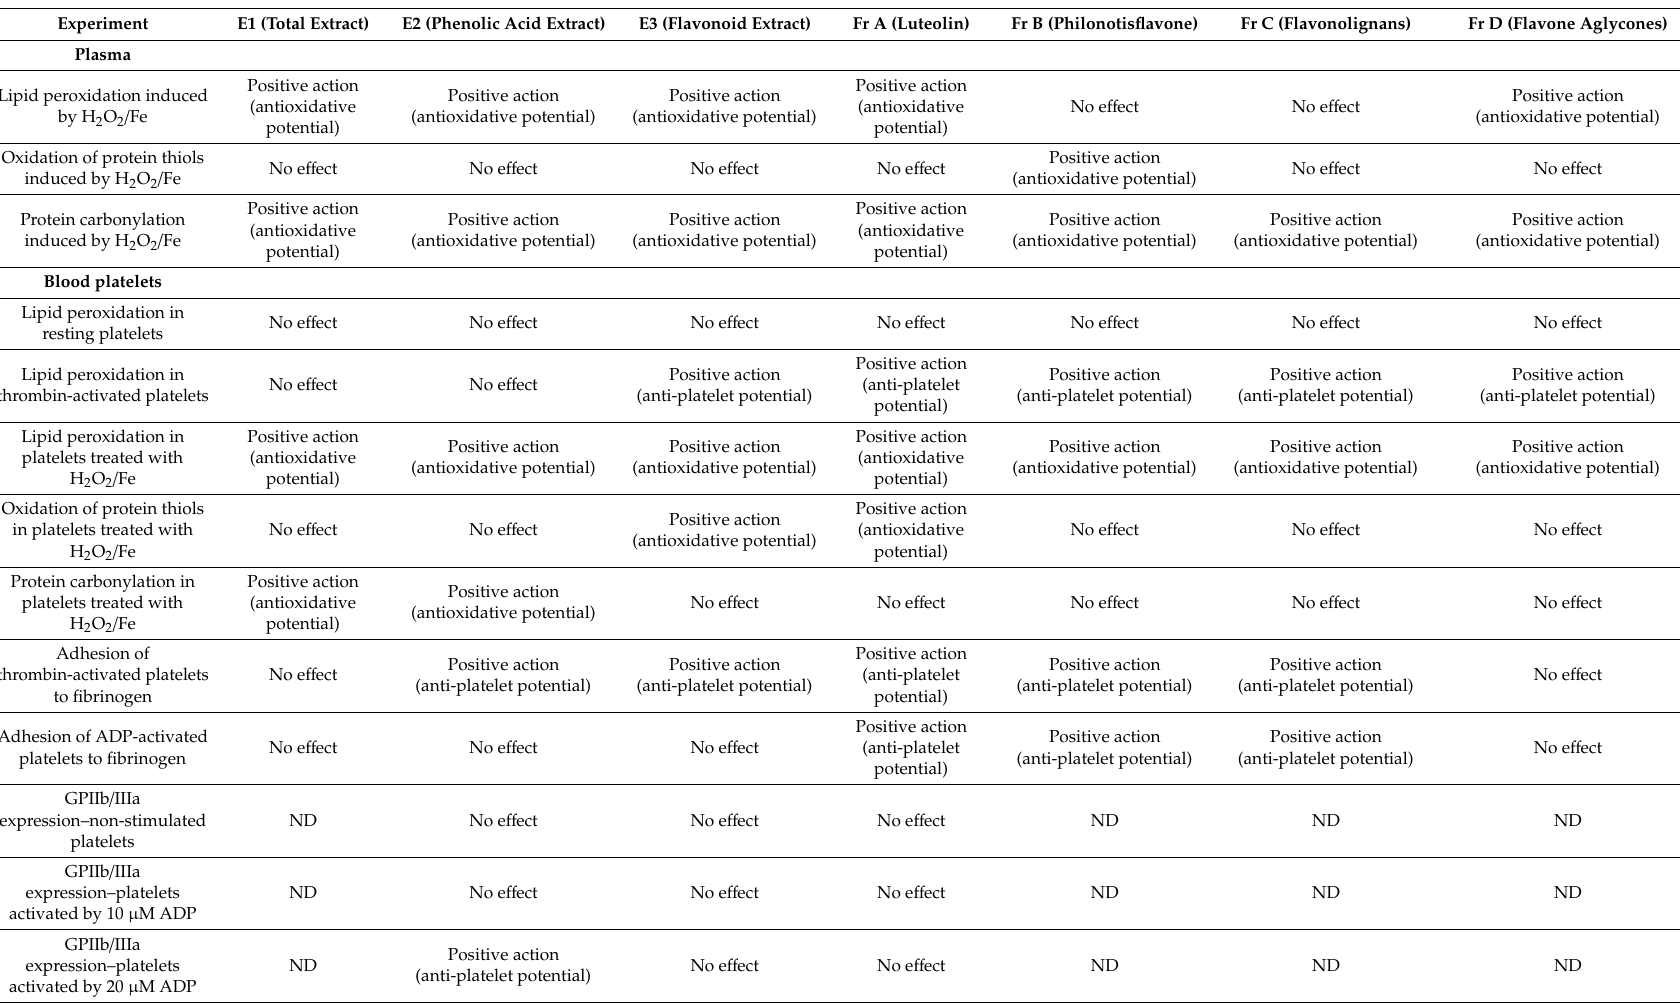
Table 5. Comparative e ff ects of extracts (E1–E3) and flavonoid fractions (A–D) of dandelion fruits (tested concentration-50 µ g / mL) on biological properties of plasma and blood